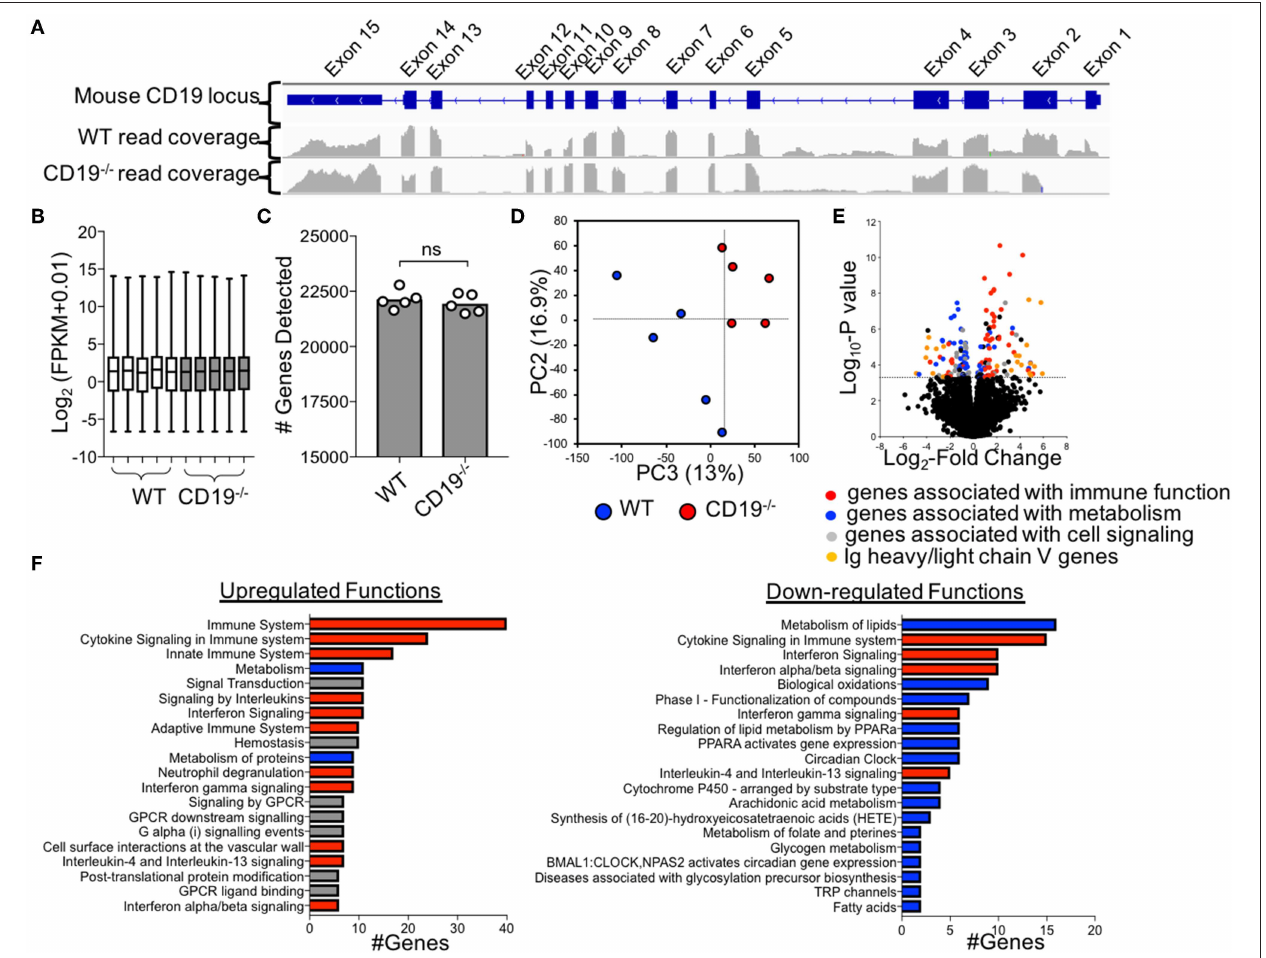
FIGURE 4 | Comparison of Ileal Transcriptomes of WT and CD19 − / − mice. (A) Read mapping across CD19 locus in WT ( n = 5) and CD19 − / − ( n = 5) mice. (B) FPKM values of normalized RNAseq data. (C) The number of genes whose transcripts were identified in RNAseq. (D) PC plot of ileal transcriptomes of WT and CD19 − / − mice demonstrating clustering by genotype. (E) Volcano plot with differentially enriched (DE) genes highlighted by function. Dotted line represents significance cutoff; FDR < 0.2. (F) Pathway (i.e., Reactome) analysis of upregulated and downregulated functions in CD19 − / − mice compared to WT controls. (F) Red bars indicate functions associated with immune response, blue bars indicate functions associated with metabolism, gray bars indicate other functions.